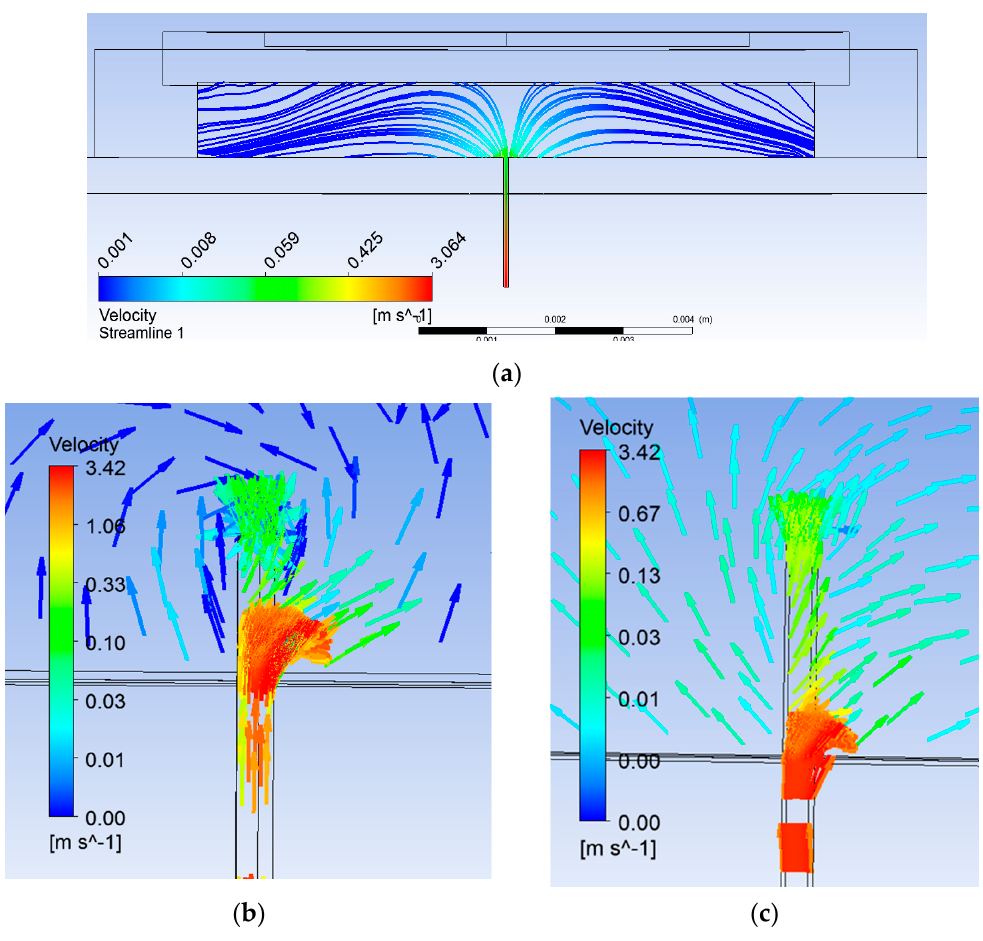
Figure 4. Streamline plot ( a ) with flushed microneedle, ( b ) 0.25-mm extended microneedle, and ( c ) 0.50-mm extended microneedle.